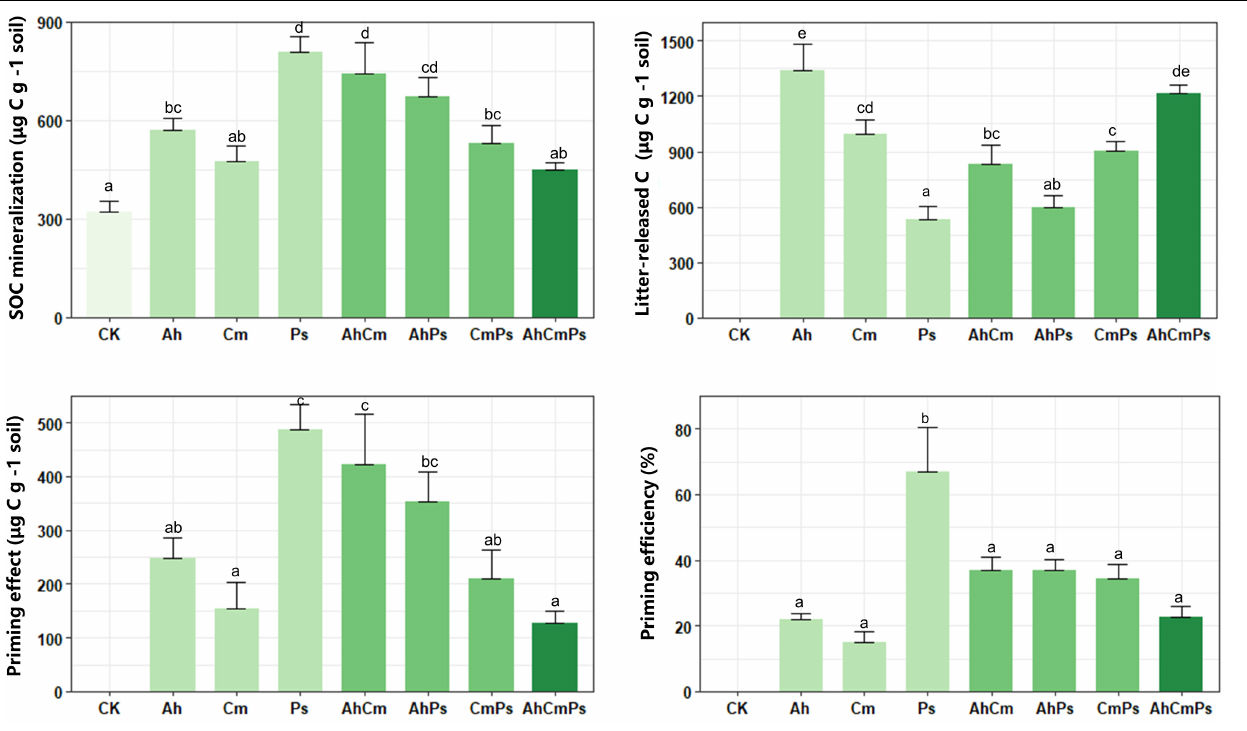
FIGURE 1 | Soil organic matter mineralization, litter-released carbon, priming effect, and priming efficiency of after additions of single-species litters and litter mixtures. The different letters indicate the significant differences between litter addition treatments ( p < 0.05). All data are presented as the mean ± SE ( n =